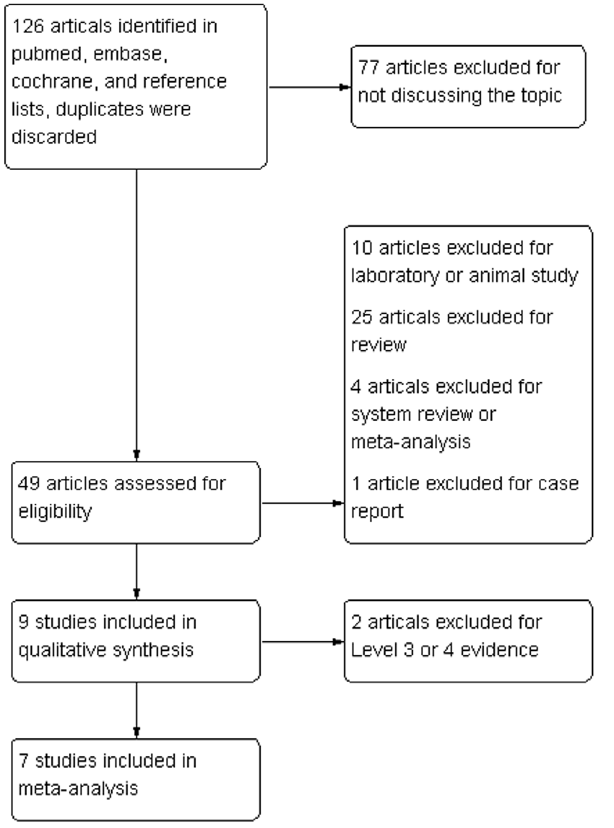
Figure 1. Search strategy flow diagram.